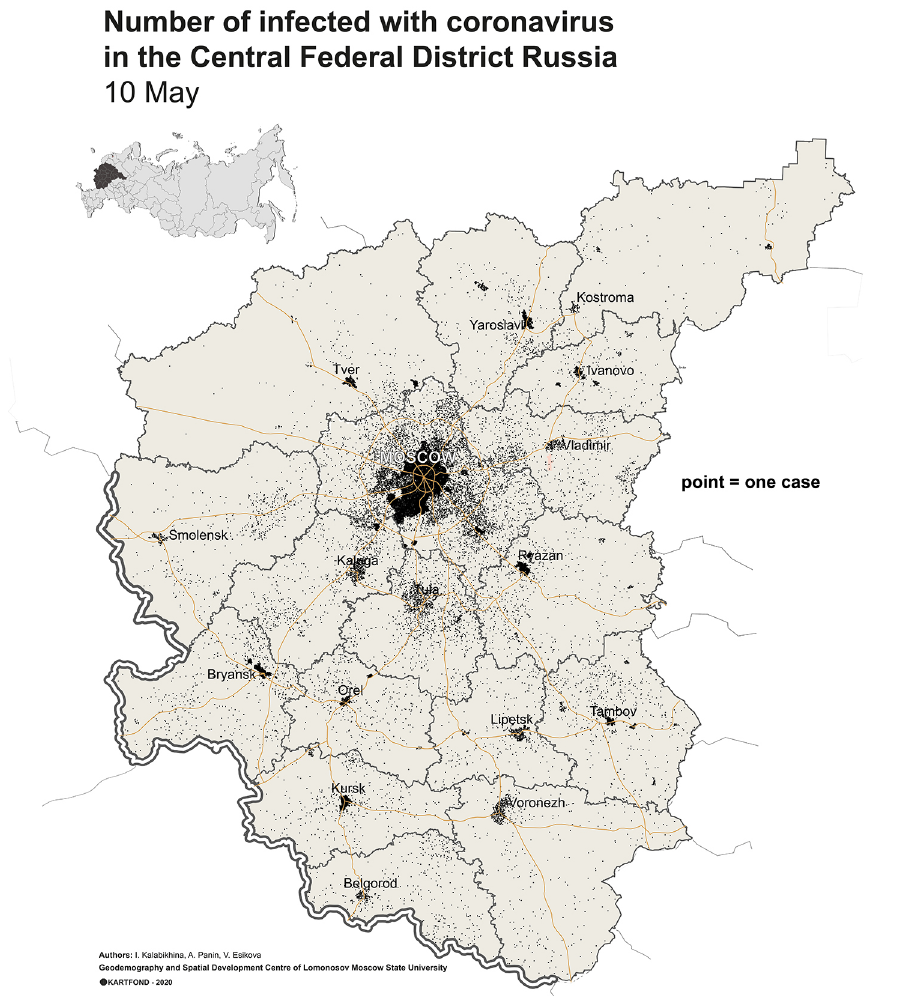
Figure 18. Geographical distribution of COVID­19 cases in the municipalities of the Central Federal District of Russia, number of reported COVID­19 cases, 10.05.2020, according to Rospotrebnadzor (2020). Source: Compiled by the researchers of the Geodemography and Spatial Development Centre of the Population Department of the Economics Faculty of Lomonosov Moscow State University to­ gether with the “Kartfond” research